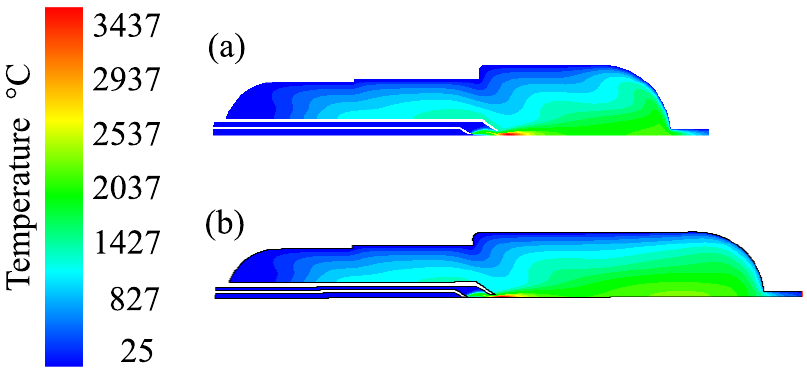
Figure 3. Temperature profile for a burner ( a ) 40 and ( b ) 70 mm in